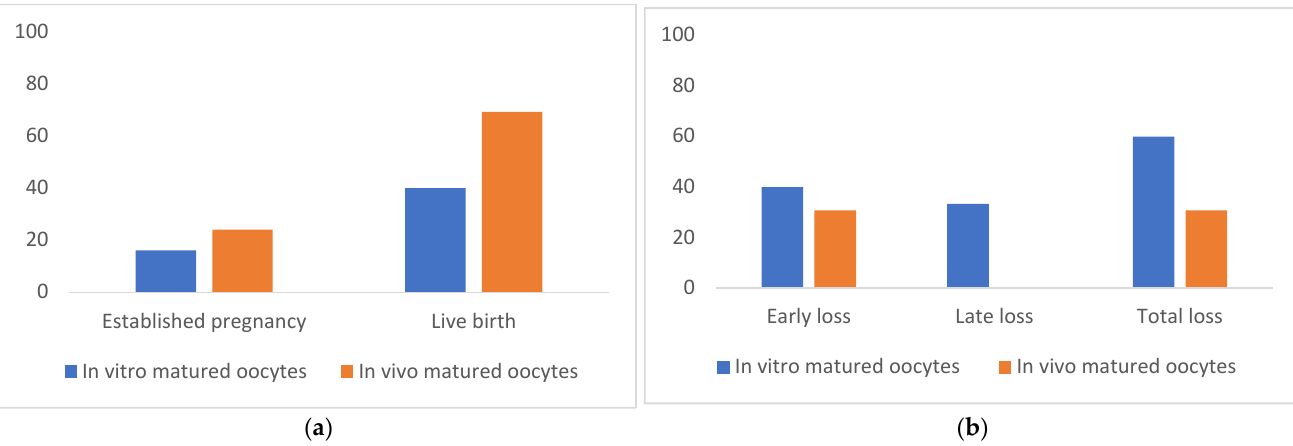
Figure 3. (a). Pregnancy and live birth rate following SCNT-derived ET (b) Pregnancy loss following SCNT-derived ET. The differences were not significant ( p > 0.05).